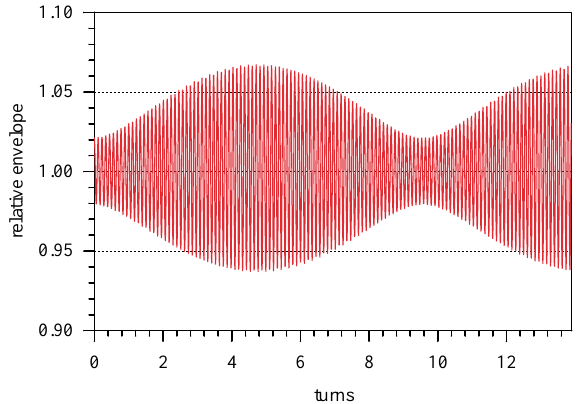
FIG. 1. (Color) Beating of envelope near half-integer imperfec- tion resonance with 10 2 3 symmetric error at harmonic n (cid:1) 9 (single particle tune on resonance with n x , y (cid:1) 4.5